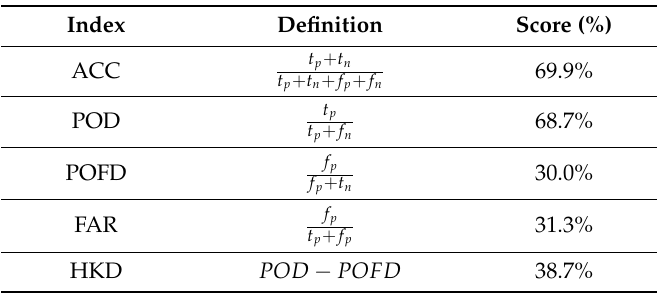
Table 7. MSG-SEVIRI SatFog evaluation